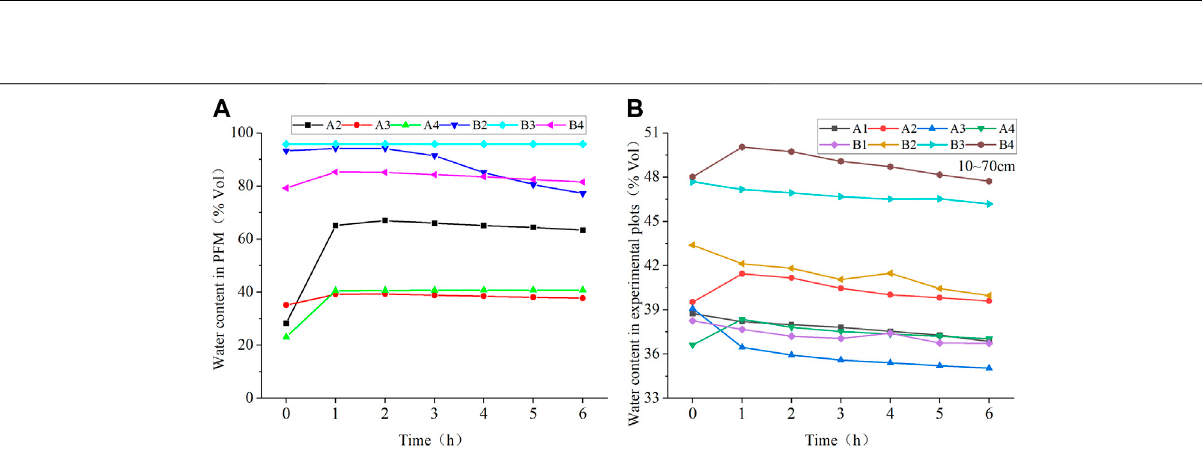
Frontiers in Earth Science |